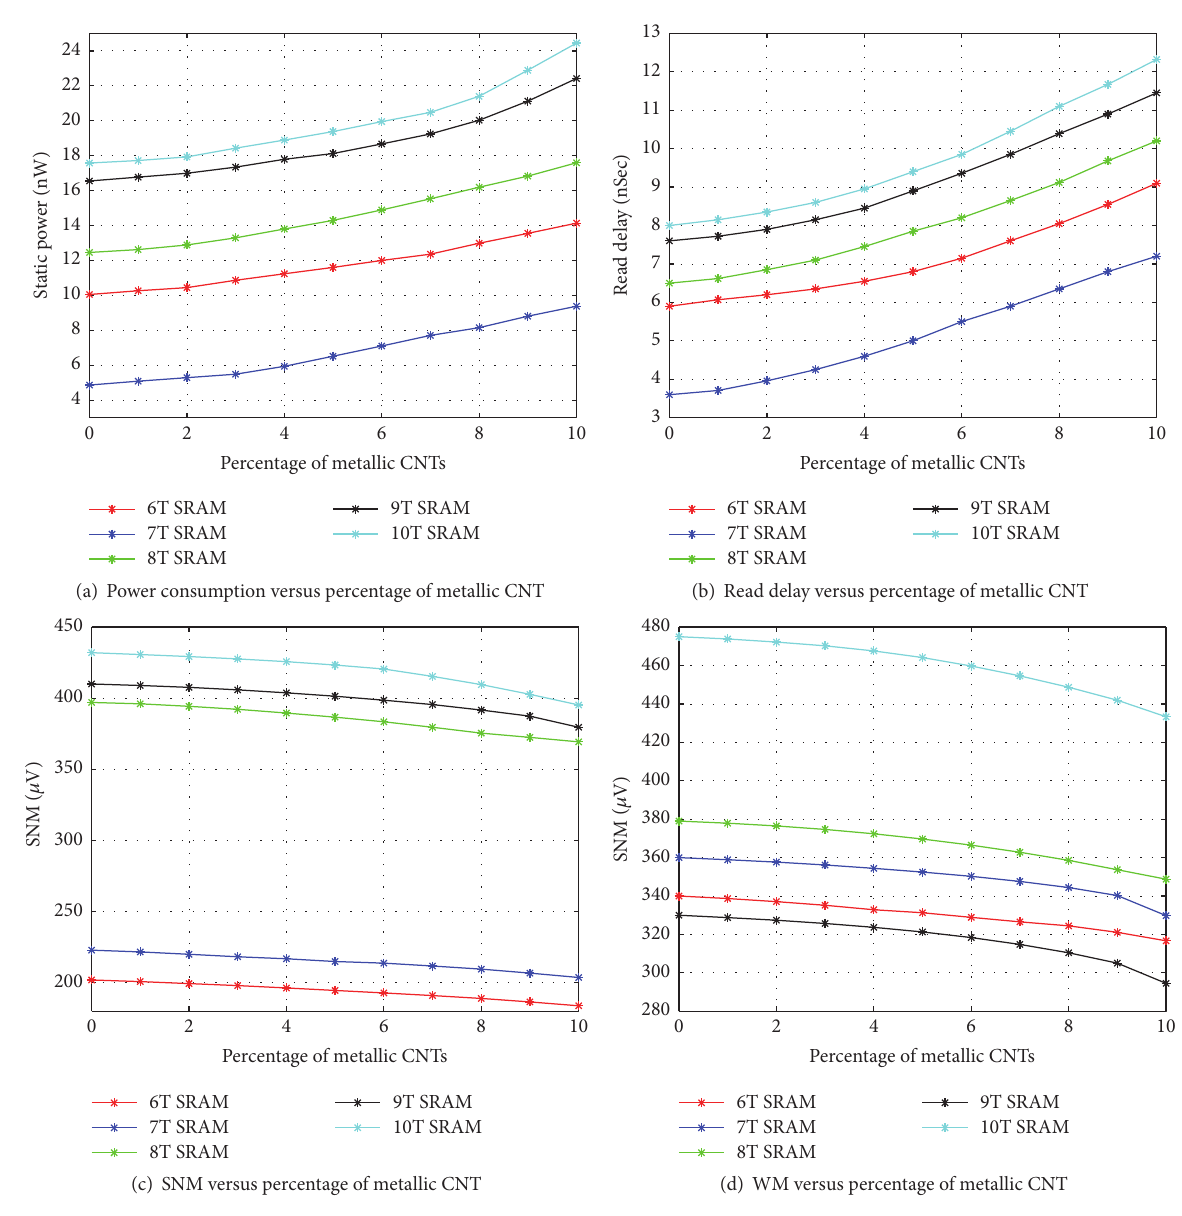
Figure 13: Dependence of SRAM characteristics on percentage of metallic